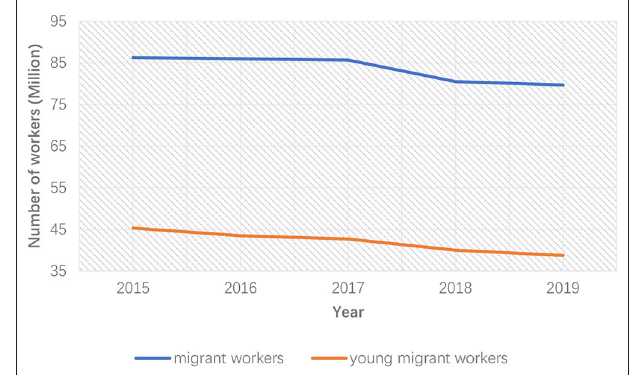
FIGURE 2 | The number of migrant workers and young migrant workers in the manufacturing industry.